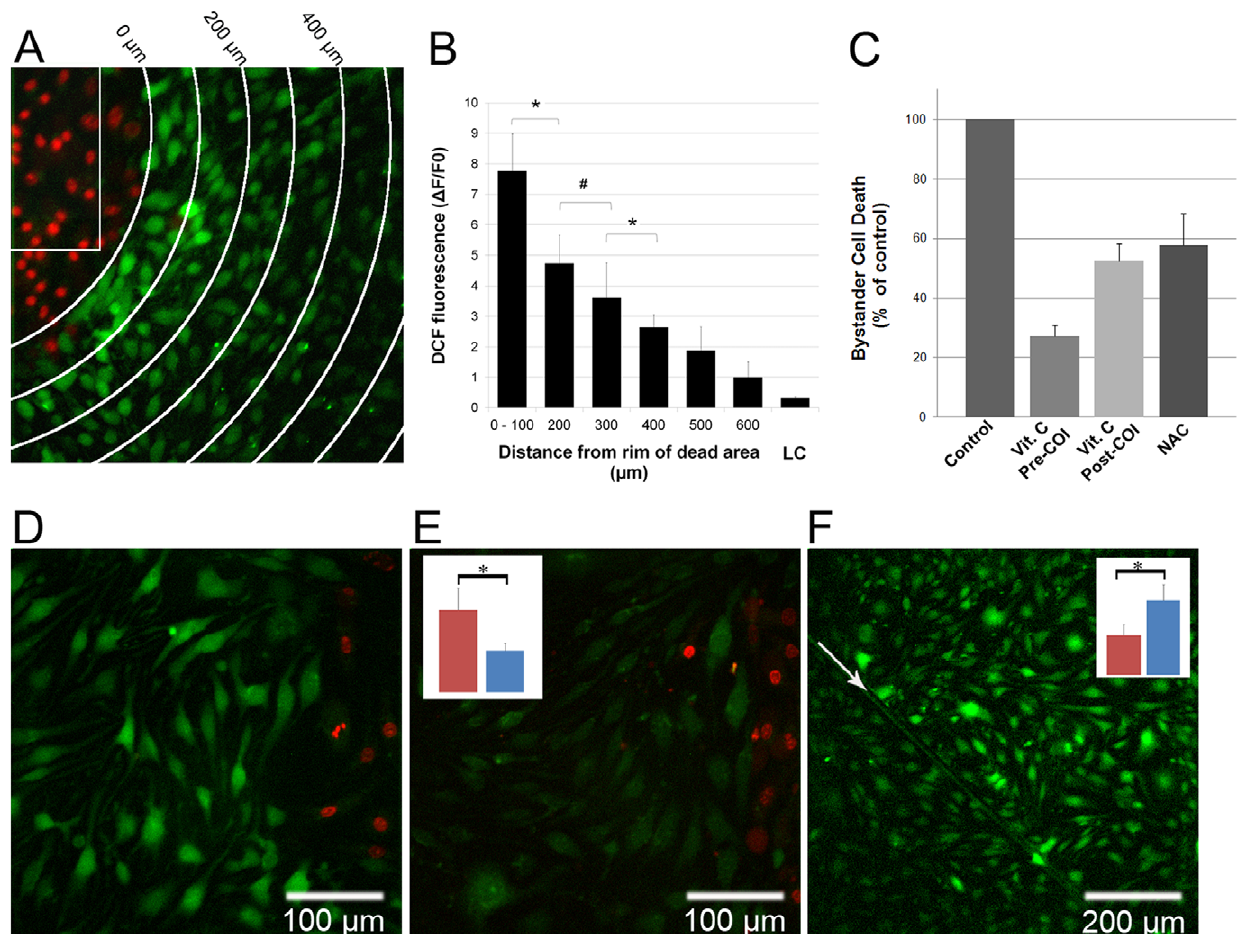
Figure 3. De-novo ROS generation in endothelial bystander cells and the effect of ROS scavengers and GJIC inhibition. bEnd.3 monolayers were incubated with DCFH-DA, rinsed with fresh culture medium and subjected to COI. After illumination the plates were placed in the incubator for 3h and then imaged for PI (pseudo-colored red) and DCF (ROS, pseudo-colored green) fluorescence. A – An overlay of two pseudo- colored captures, the white arches represent distance increments of 100 m m from the COI (white rectangle), representative of n=3. PI + bystander cells on the top left corner are at 50–100 m m from the rim of the COI. Adjacent to them on the first arch (0–100 m m) are DCF positive, PI negative bystander cells. B – A plot of DCF fluorescence intensity (mean 6 SD of five cells in three separate experiments). LC – light control, cells exposed to laser illumination, without WST11 incubation, imaged for DCF fluorescence 3h later. C – bEnd.3 monolayers were subjected to COI under the following conditions: Control: encompassing standard COI; Vit. C Pre-COI: encompassing incubation with 100 m mol/L vitamin C for 1h, rinse and then subjected to COI; Vit. C Post-COI: encompassing the addition of 100 m mol/L vitamin C immediately after COI; NAC: incubation with 10mmol/L NAC prior to COI. 3h after COI, cell death was determined by PI fluorescence. Notably, in all cases COI resulted in a complete cell death within the primary illuminated square. Values represent averaged percent of bystander cell death (mean 6 SD of at least n=3 separate experiments in each group) relative to the control. The control values are statistically significant higher than all treated groups (P , 0.01). D, E – bEnd.3 monolayers were incubated with GZA (D) or CBX (E), respectively, subjected to COI and probed with DCFH-DA. Dead bystander cells (red) at a distance of 60–80 m m from the rim of COI, are accompanied by PI 2 , DCF + (representative of n=3 experiments) in (D) but not in (E). The insert in (E) illustrates the mean DCF fluorescence of CBX compared to GZA treated cells (right and left colum respectively, n=10 cells) at equal distances from the dead bystander cells. *- P , 0.01 between the treatments. # - P , 0.05. F – bEnd.3 monolayers were scratched by a surgical scalpel (arrow), underwent COI (near the upper right corner), and placed in the incubator for 10h. Intra-cellular ROS propagation (DCF + ) is blocked at the scratch. Insert – right and left columns representing mean DCF fluorescence intensities in the photoactivation side and beyond the scratch, respectively). * P ,